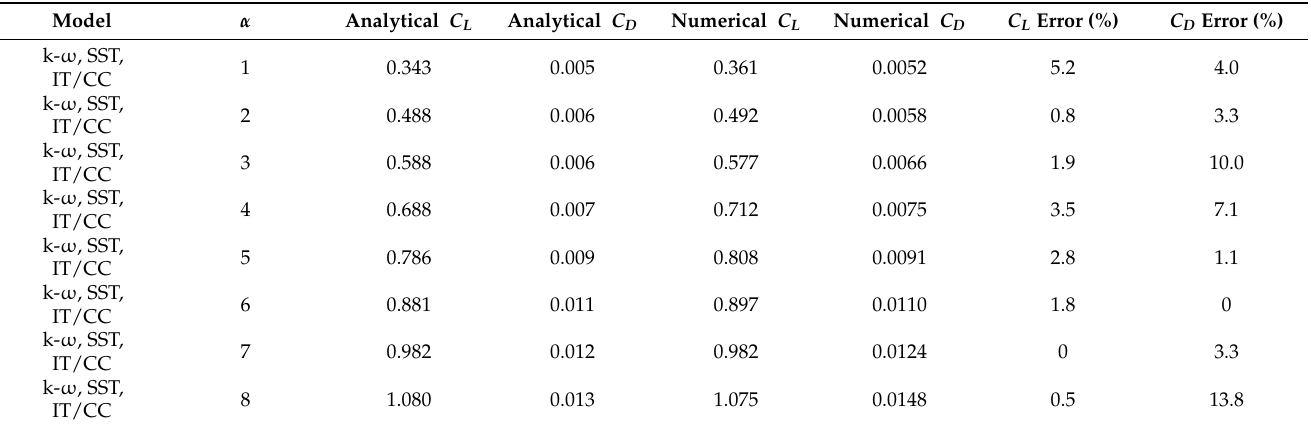
Table 4. Benchmarking of NACA2410 simulated results against analytical